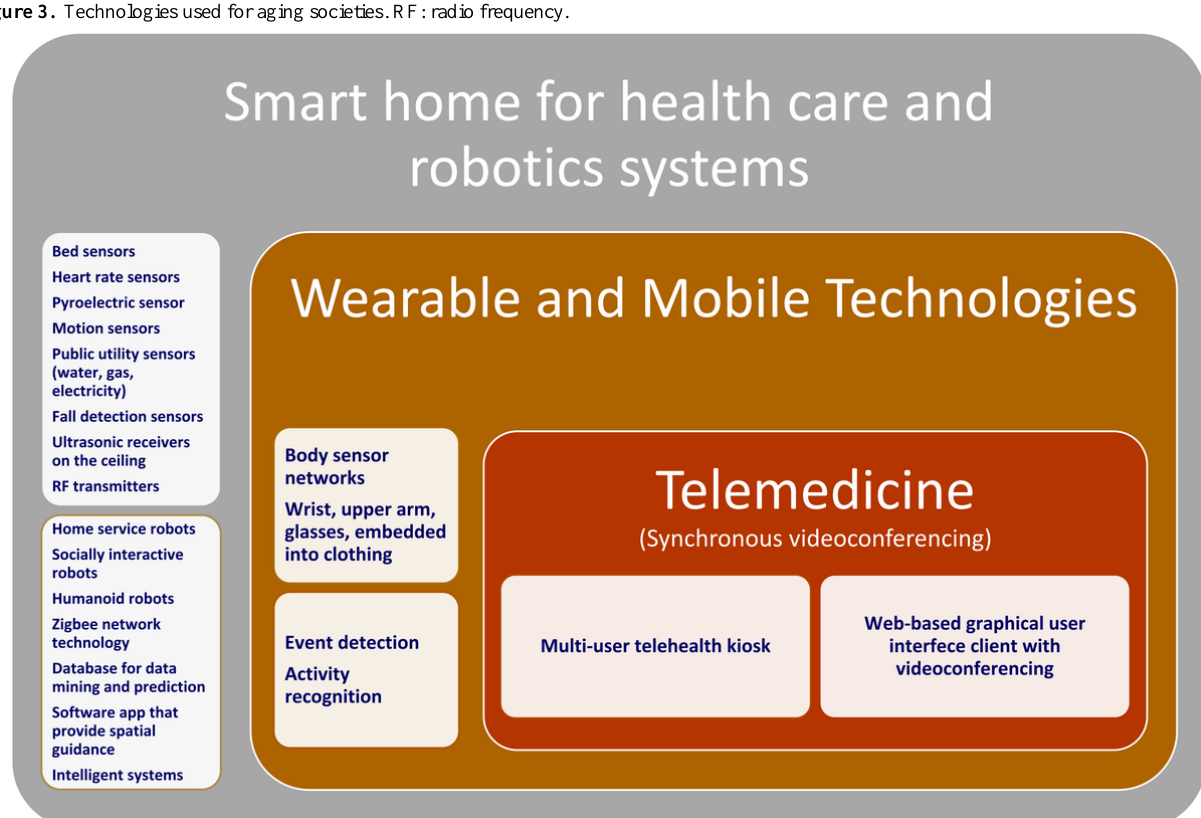
Figure 3. Technologies used for aging societies. RF: radio